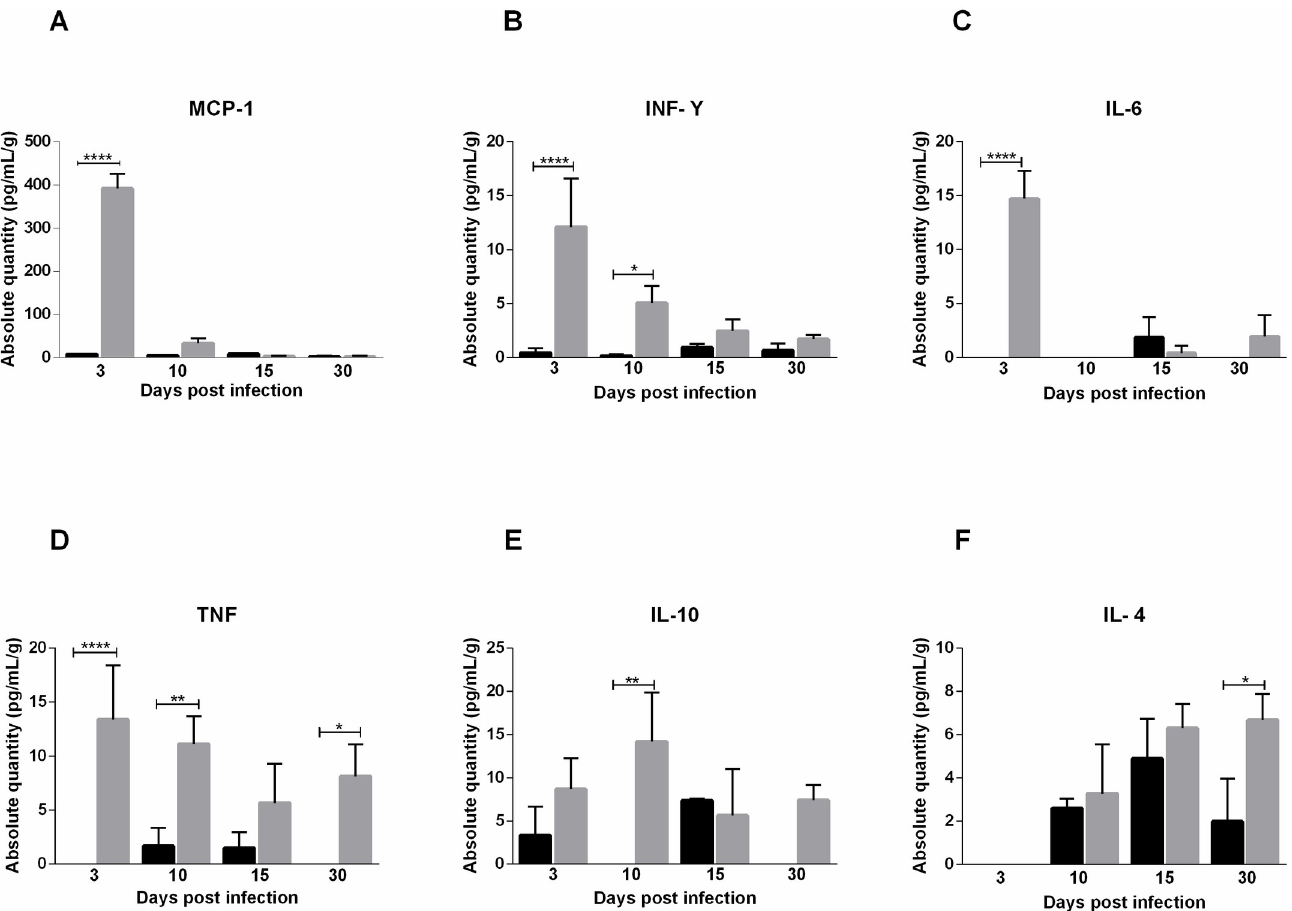
Fig 11. Cytokine profile of 15-day old Balb/c mice infected via the rear footpad with 2.57 x 10 6 PFU. Serum was collected 3, 10, 15 and 30 days post-infection for analysis of soluble factor levels. The levels of MCP-1 (A), TNF (B), INF- γ (C) and IL-6 (D) were elevated on day 3 PI. At day 10, TNF (B) and INF- γ (C) remained high and the level of IL-10 (E) was elevated. At day 30 PI TNF (B) and IL-4 (F) were present. Statistics were performed with one-way ANOVA, Bonferroni’s multiple comparisons test. Gray bars: Infected. Black bars: negative control. ( � P value � 0.05; �� P value � 0.01; ���� P value � 0.0001). N = 3 animals/